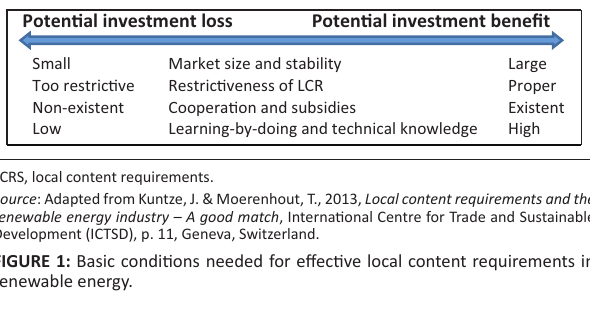
FIGURE 1: Basic conditions needed for effective local content requirements in renewable